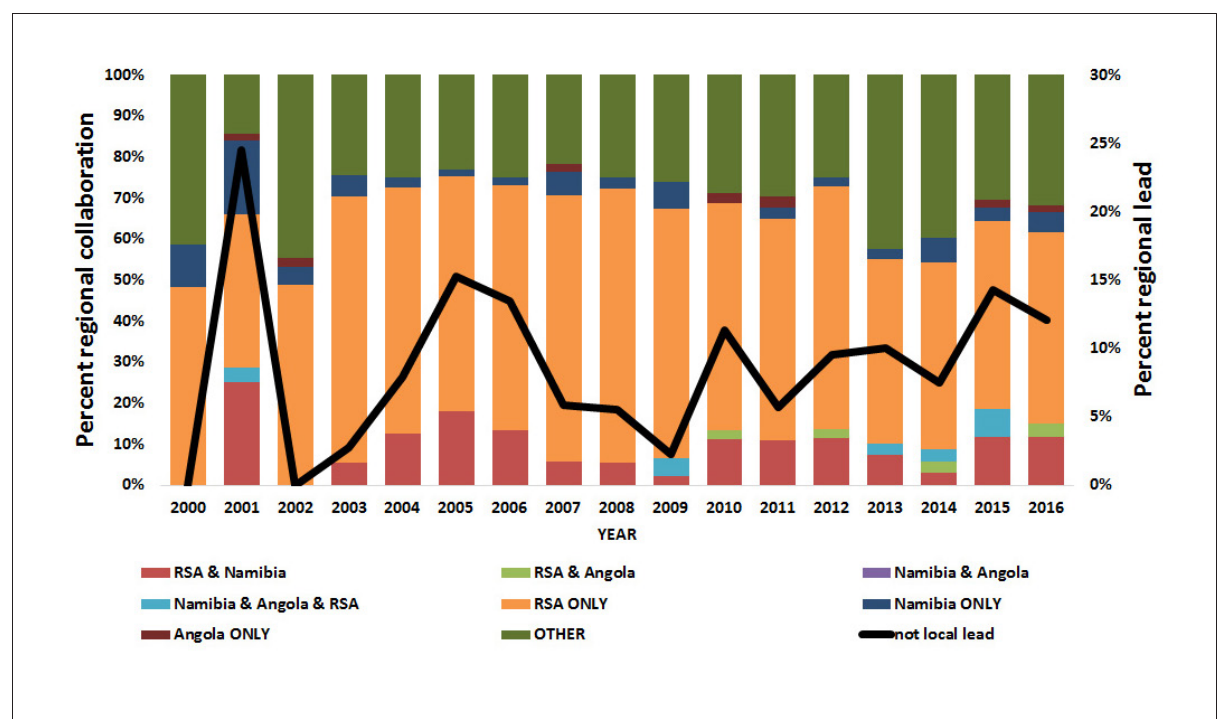
Figure 1: Per cent participation in peer-reviewed journal publications on the resources and/or environment of the Benguela Current Large Marine Ecosystem (BCLME) region during the period 2000–2016 by regional country in isolation, or collaboration. Also shown are the relative contributions that did not include a regional collaborator. Line shows per cent regionally led publications. Numbers of papers published each year from Table